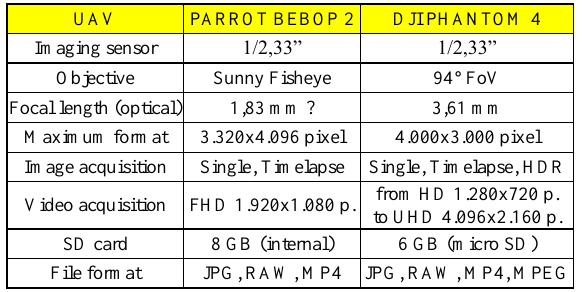
Table 2: Main imaging features of Bepop 2 and Phantom 4.